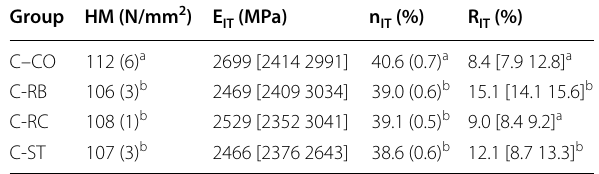
Mean values and standard deviations (in parentheses) or median and 25% and 75% percentiles (in brackets). Same superscript letters show groups without statistical differences per property ( p > 0.05)